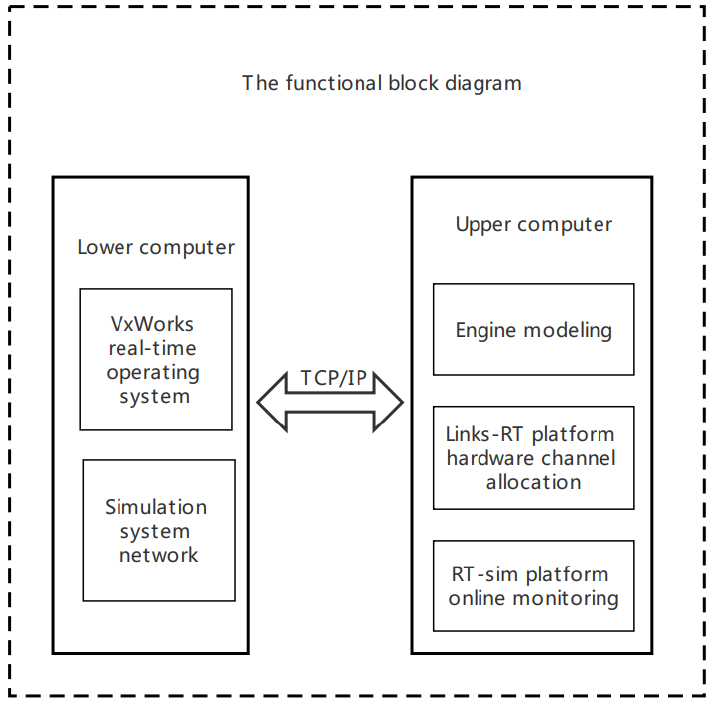
Figure 1. The functional block diagram.